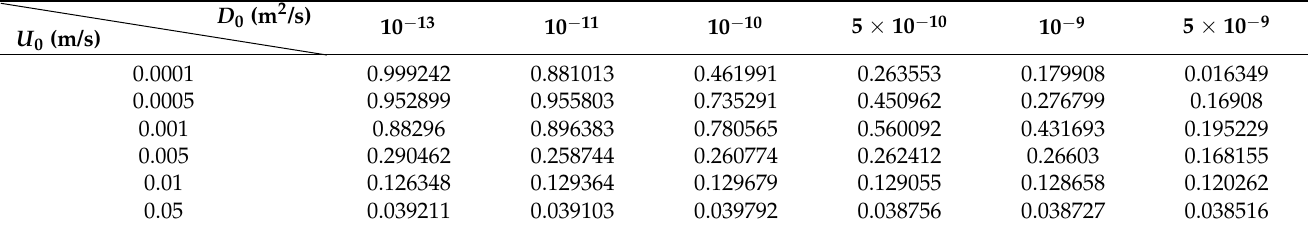
Table 3. NUC value normalization ( NUCN ). Table 3. 𝑁𝑈𝐶 value normalization ( 𝑁𝑈𝐶𝑁 ).